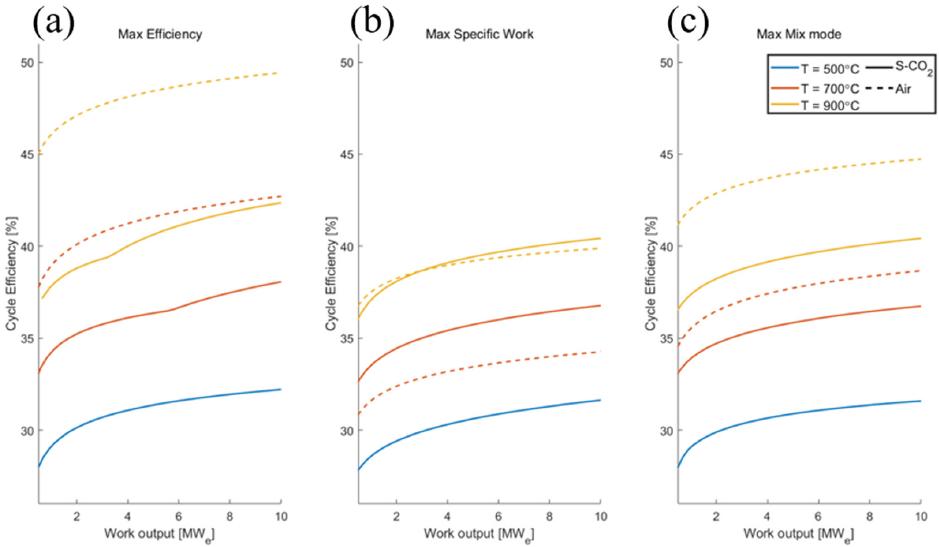
Figure 28. Cycle Efficiency for ( a ) maximum efficiency, ( b ) maximum specific work, and ( c ) maximum mix mode.